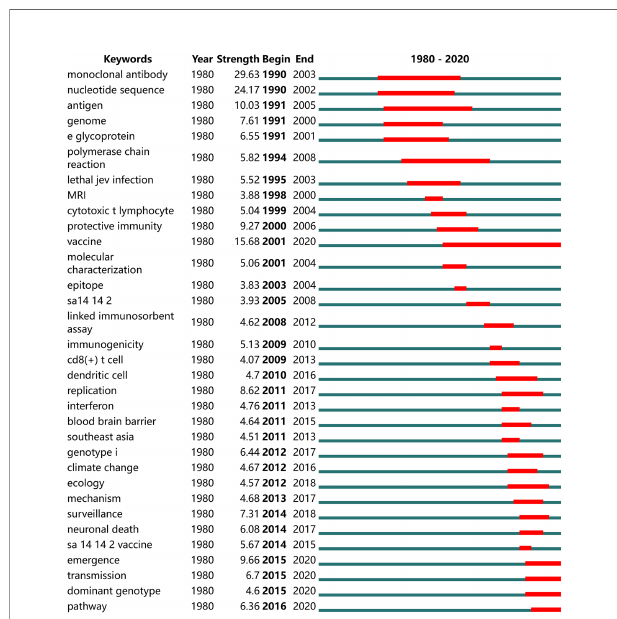
FIGURE 4 | Keywords with the strongest citation burst in publications on JE research from 1980 to 2020. The time interval is depicted as a blue line. The period in which a keyword is found to exhibit a strong increase is shown as a red line, which indicates the beginning and the end year of the